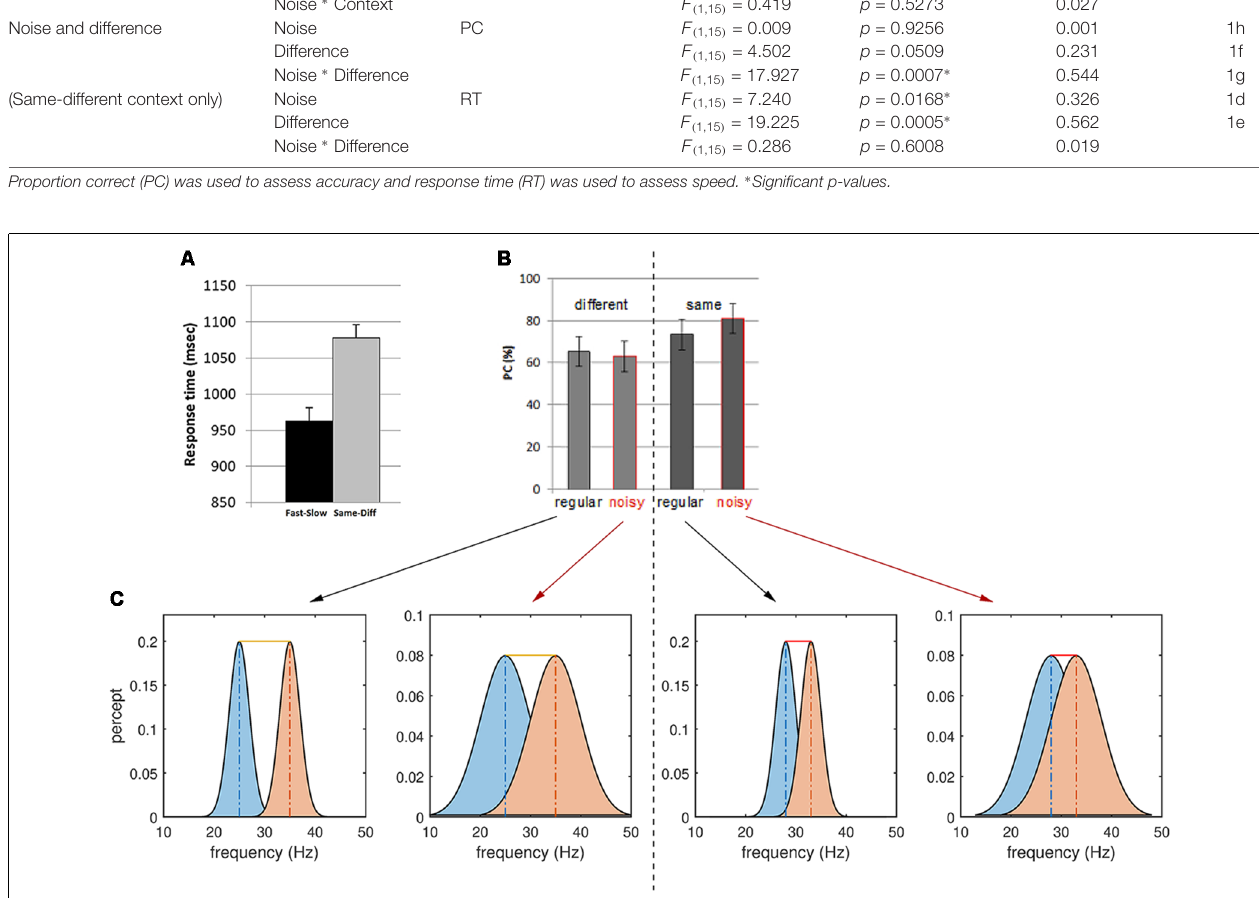
same trials, accuracy was greatest when trials were